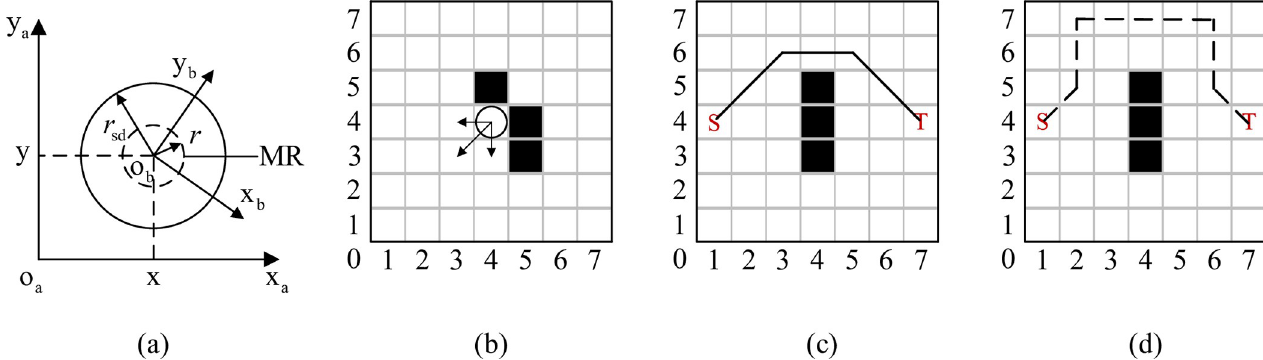
Fig 1. Path planning problem formulation: (a) Schematic diagram of MR; (b) Direction of motion when there is an obstacle around the MR; (c) Short path length condition; (d) Safe path length condition. (Circle for MR; white grid for S free ; black grid for S obs ; solid black line is the path planned by SSQL).